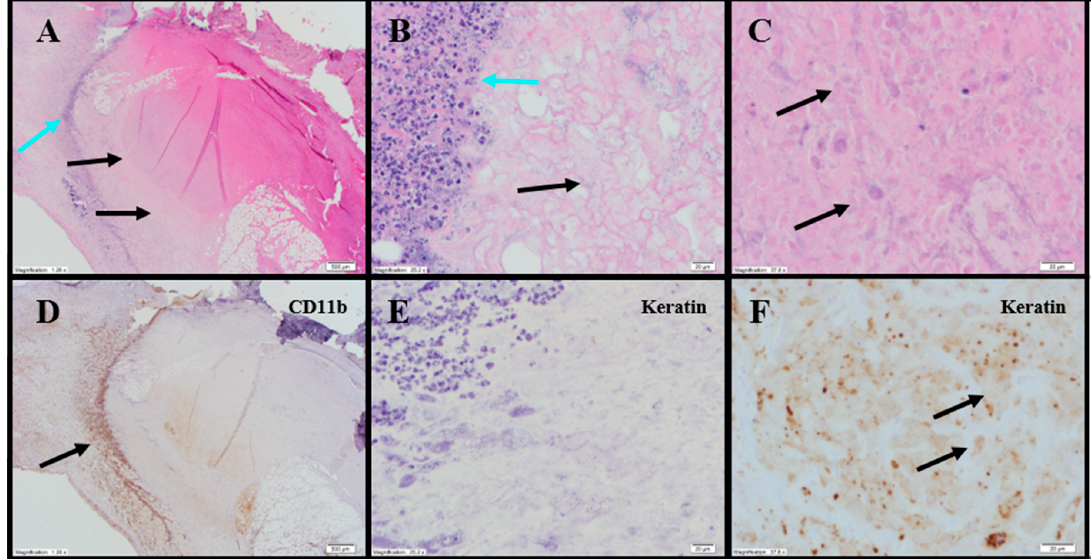
Figure 4. Representative photomicrographs of renal tumors administered 1 × IT NanoDoce ® . ( A ) Skin ulceration (top right). Extensive tumor cell necrosis (TCN) (black arrows) with a band of necrotic debris and admixed immune cells (ICs) (blue arrow) between the necrotic tumor and inflamed host tissue 2 × . ( B ) Line of demarcation shows a dense collection of ICs, admixed debris (blue arrow) and adjacent necrotic material with no viable tumor (black arrow) 40 × . ( C ) Central necrosis in ( A ): ghost outlines of necrotic tumor cells (TCs) (black arrows) 60 × . ( D ) Same as panel ( A ): anti-CD11b highlights the dense IC infiltrate (black arrow) 2 × . ( E ) Same band of necrotic debris as panel ( B ): complete absence of anti-AE1 / AE3labelling 40 × . ( F ) Similar section of tissue as panel ( C ): anti-AE1 / AE3 shows degenerating keratin filaments in the necrotic ghost-cell outlines (black arrows) supporting theory that previously viable carcinoma underwent complete regression and necrosis 60×.